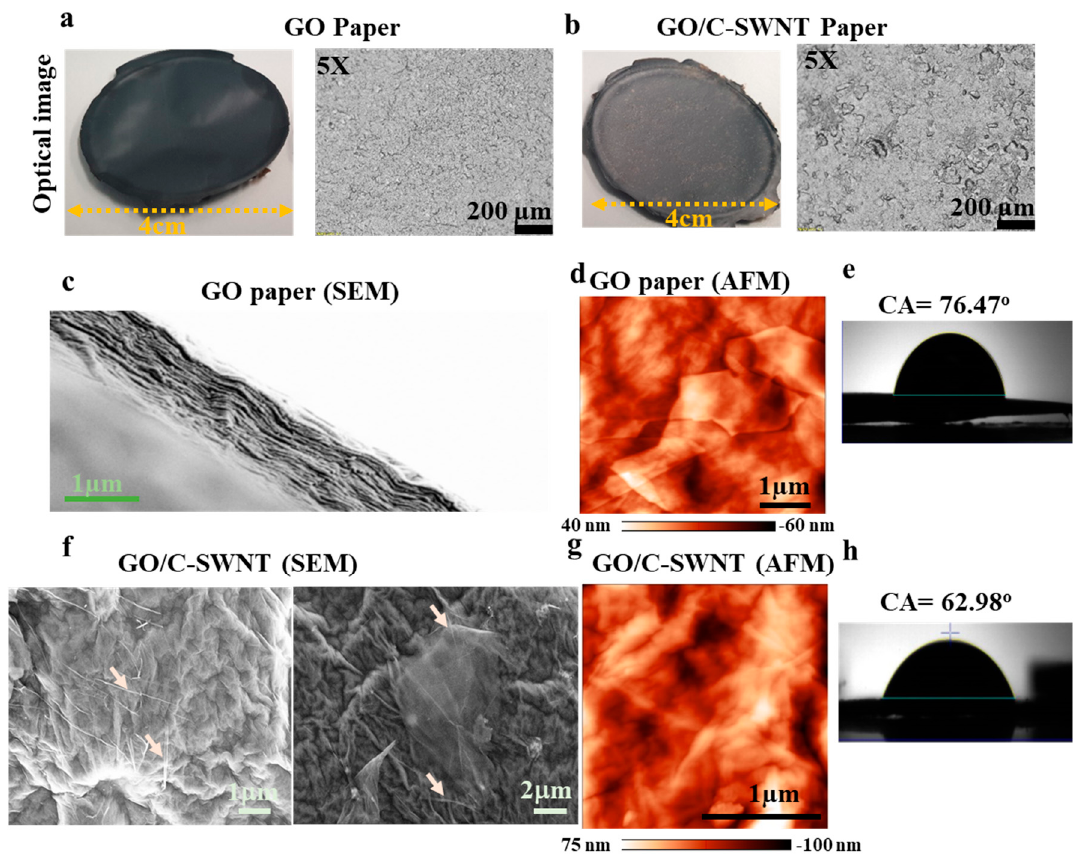
Figure 1. ( a ) Photograph (4 cm) and optical image resolution (5×) for free-standing GO and ( b ) of GO/C-SWNT paper. ( c ) SEM image (the background has been whitened, for clarity) of a GO-paper showing packing of each GO layer conglomeration. ( d ) AFM image of individual GO sheets cross-stacked to produce a GO-paper. ( e ) A water drop profile on a GO sheet with a contact angle of 76.47° over GO sheets. ( f ) SEM image of a GO/C-SWNT paper shows entangled CNTs network; inset reveals an area of the cross-section. ( g ) AFM image of GO/C-SWNT paper shows disruption of GO sheet arrangement in vertical stacking, some C-SWNT are shown by marked arrows. ( h ) The water contact angle measurement of the GO/C-SWNT paper is 62.98° showing higher hydrophilic characteristics than GO-paper. The “+” sign indicates the focused location of the objective lens at the topmost curvature of water droplet.